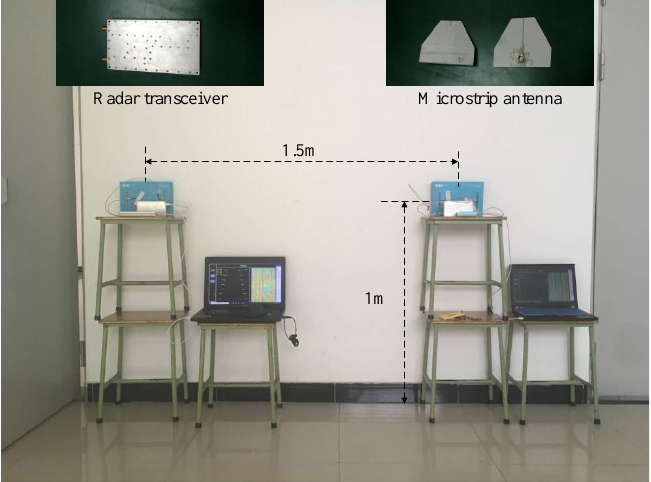
Figure 4. Deployment of dual-station